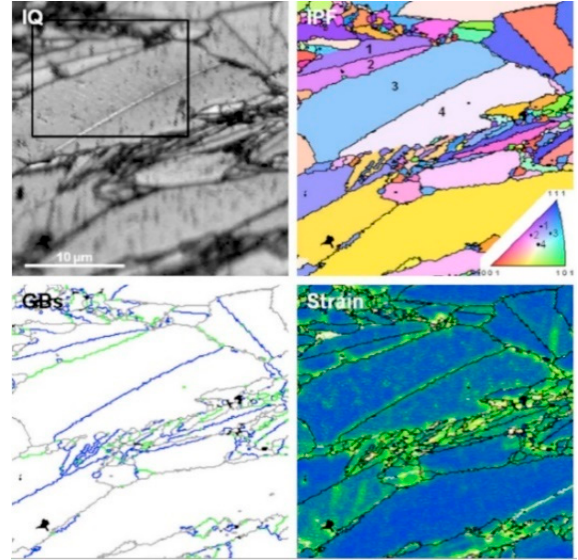
Figure 34. Electron Back-Scatter Diffraction (EBSD) analysis of the cross-section surface (28 × 28 µm) of the sample exposed to the SCW with 10 ppb oxygen for 333 h. GBs denote grain boundaries with blue, green and gray lines denoting three different network, and general boundaries. Reprinted with permission from Reference [101]. Copyright 2009 Elsevier.